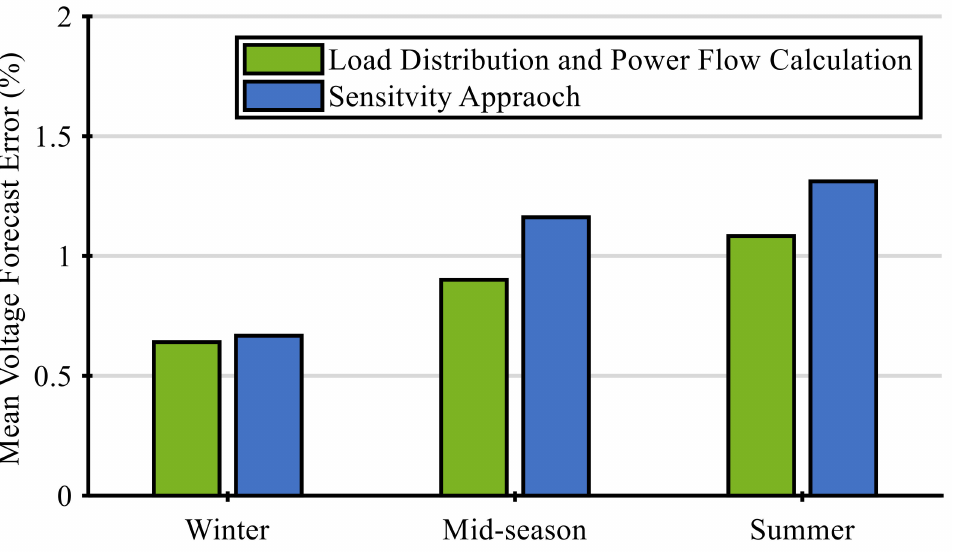
Figure 10. Evaluation of the error increase in one LV grid by using the sensitivity